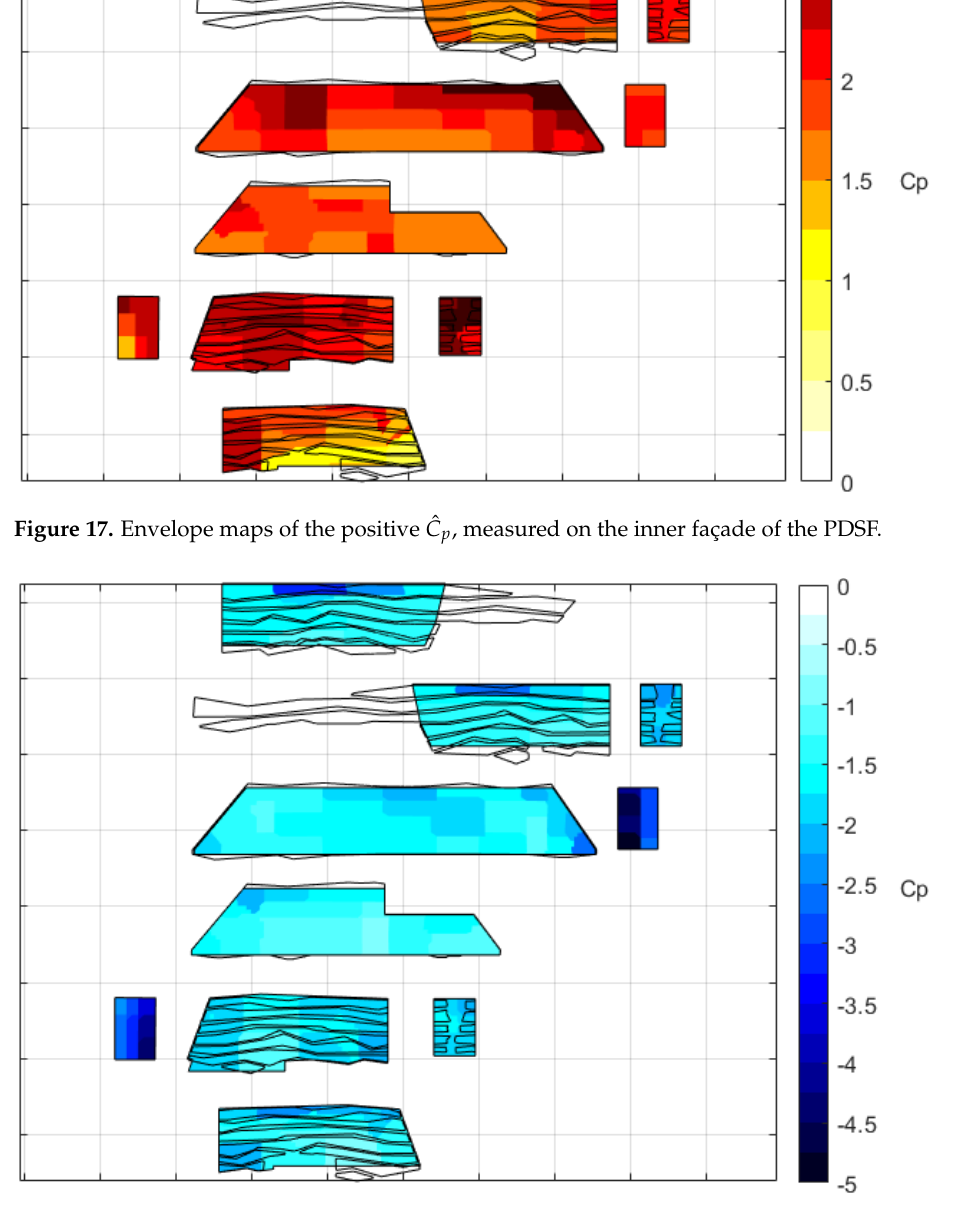
Figure 18. Envelope maps of the negative ˇ C p , measured on the inner façade of the